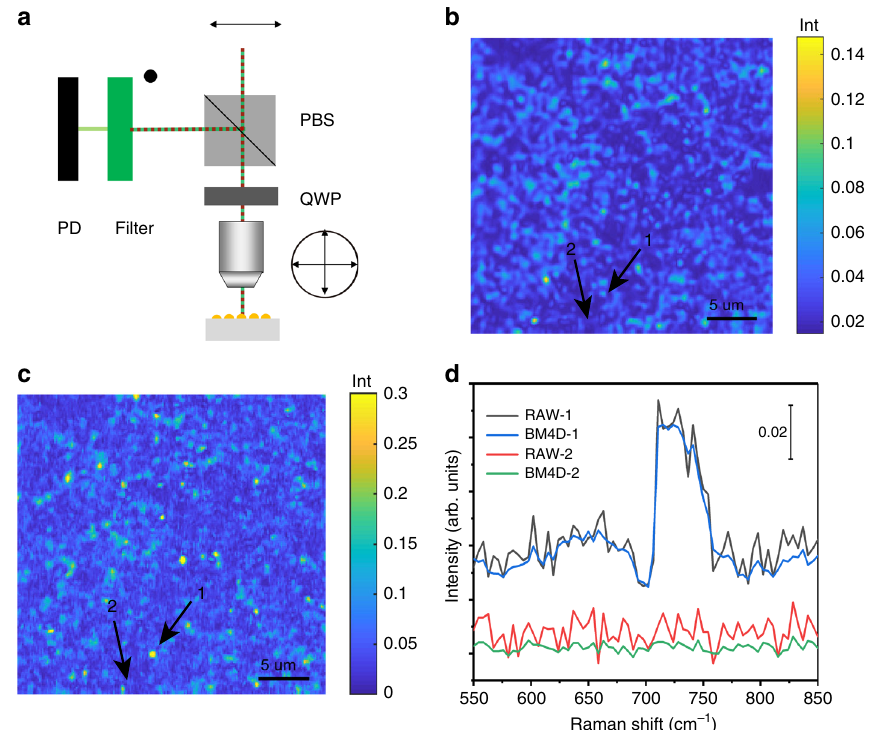
Fig. 3 Epi-detected PESRS. a A schematic of epi-detected PESRS. A polarizing beam splitter (PBS) and a quarter wave plate (QWP) changes the polarization of incoming and backscattered lasers by 90°. In this way, the stimulated Raman loss signal passes the fi lter and is detected by a photodiode (PD). b Raw PESRS image of adenine adsorbed on Au NPs-SiO 2 substrate. The color of each pixel represents the average intensity of each PESRS spectrum. c Denoised PESRS image of adenine adsorbed on Au NPs-SiO 2 substrate. The color of each pixel represents the intensity of the 733 cm − 1 peak in each denoised and background-corrected PESRS spectrum. The image area is 30 μ m × 30 μ m. d Single-pixel spectra of adenine on the Au NPs-covered SiO 2 substrate obtained from spot 1 and 2 indicated in c